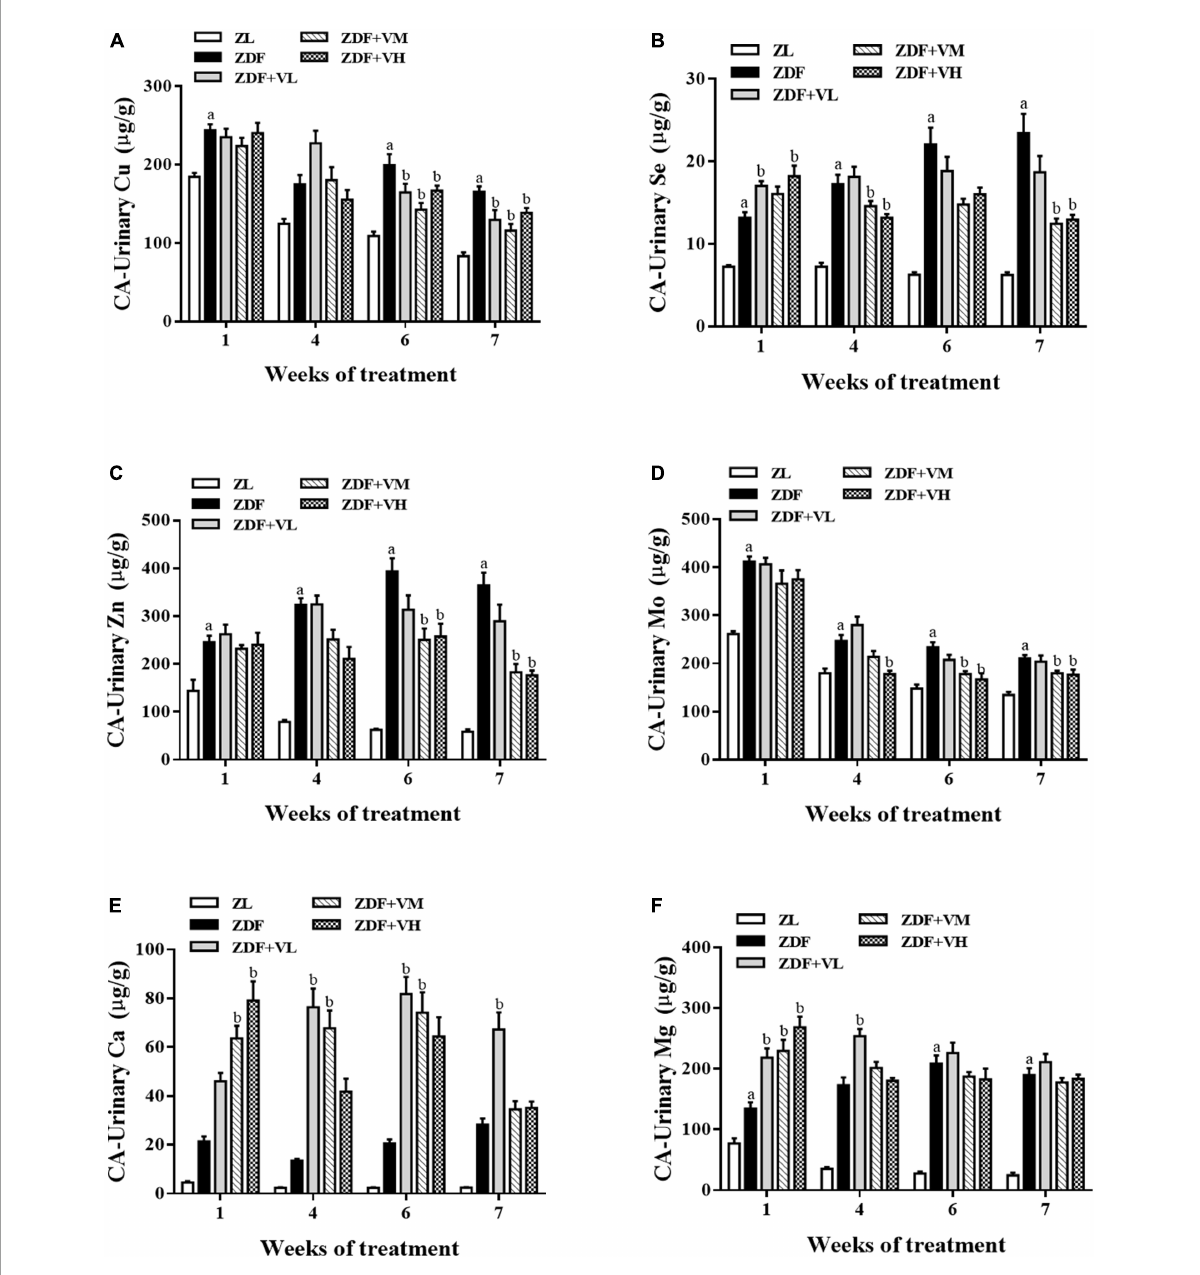
FIGURE3 Effect of 1,25(OH) 2 D 3 on urinary mineral levels in Zucker rats. (A) Urinary Cu/UCR. (B) Urinary Se/UCR. (C) Urinary Zn/UCR. (D) Urinary Mo/UCR. (E) Urinary Ca/UCR. (F) Urinary Mg/UCR. ZL, Zucker lean group; ZDF, Zucker diabetic fatty group; ZDF + VL, ZDF + low-dose 1,25(OH) 2 D 3 group (2 µ g/kg · bw); ZDF + VM, ZDF + middle-dose 1,25(OH) 2 D 3 group (8 µ g/kg · bw); ZDF + VH, ZDF + high-dose 1,25(OH) 2 D 3 group (16 µ g/kg · bw). Data are presented as mean ± SEM ( n ≥ 9). a P < 0.05 vs. the ZL group, b P < 0.05 vs. the ZDF